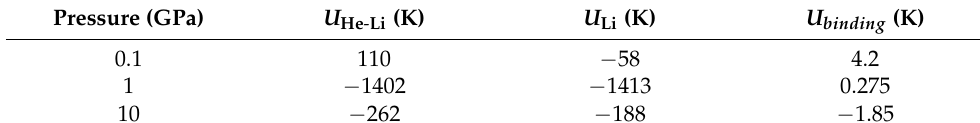
Table 2. Binding energies of helium at 800 K as a function of the pressure.